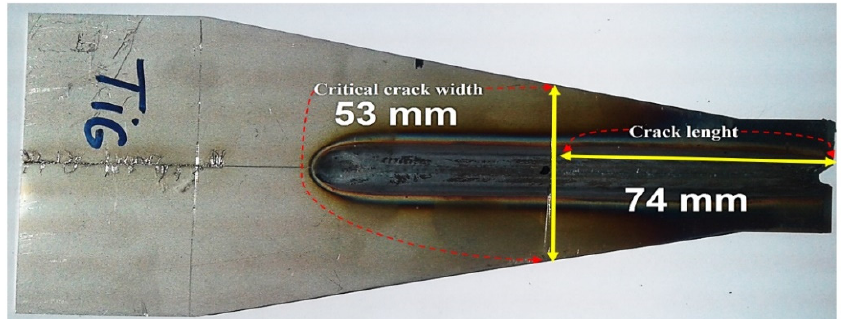
Figure 5. TIG-welded specimen without adding powders, face side.